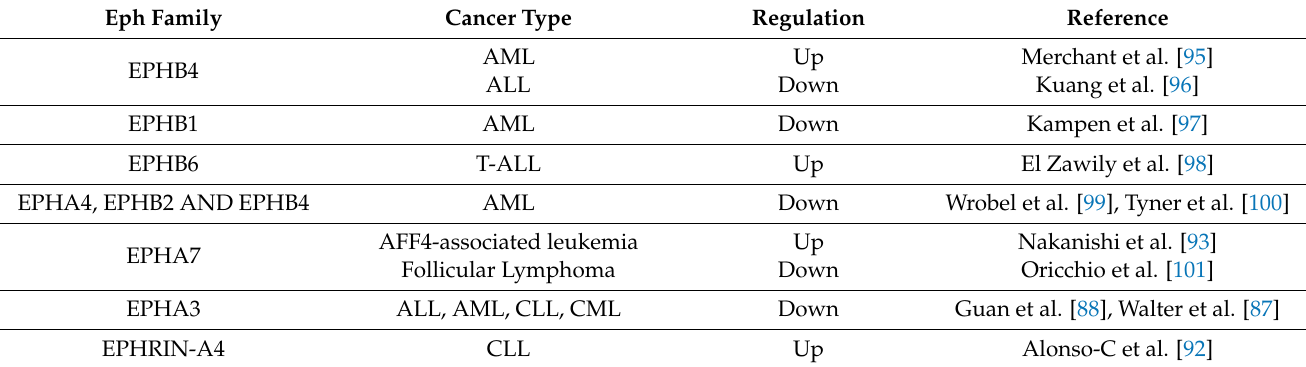
Table 2. Examples of the regulation of Eph family members in haematopoietic malignancies. Eph